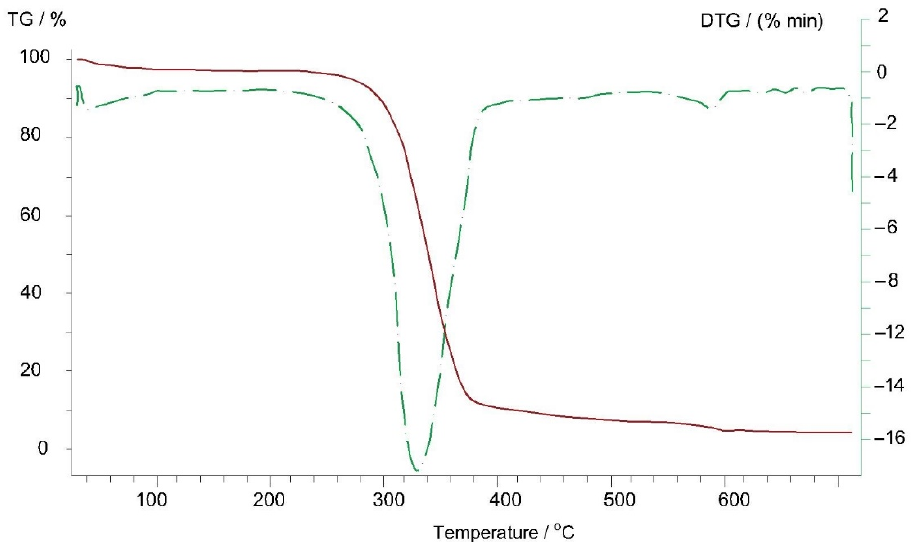
Figure 11. Thermogravimetric curve of the Arboform ® LV3 Nature sample.